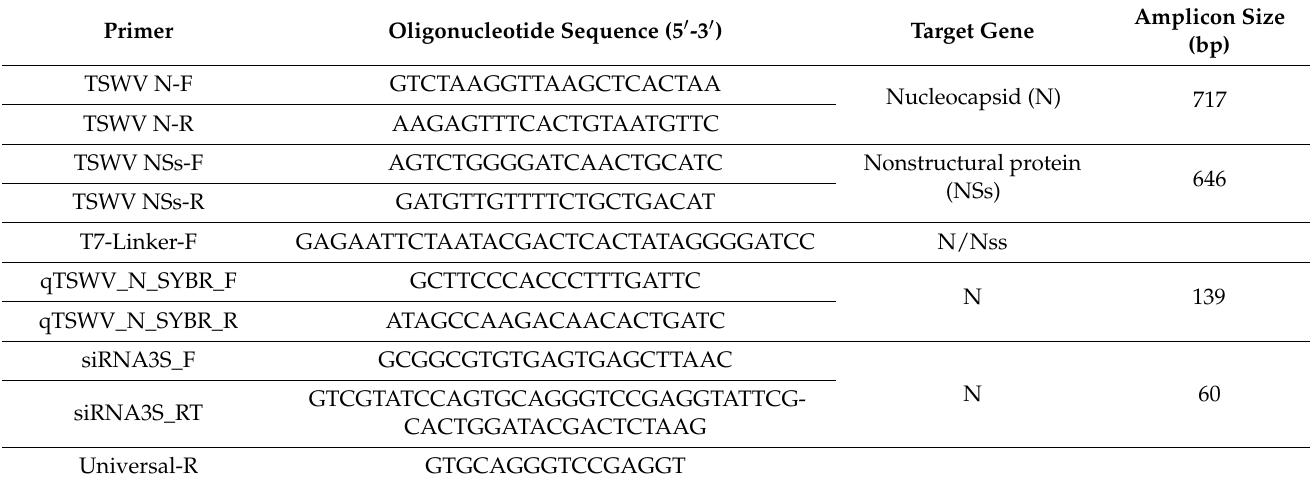
Amplicon Size (bp) Nucleocapsid (N) 717